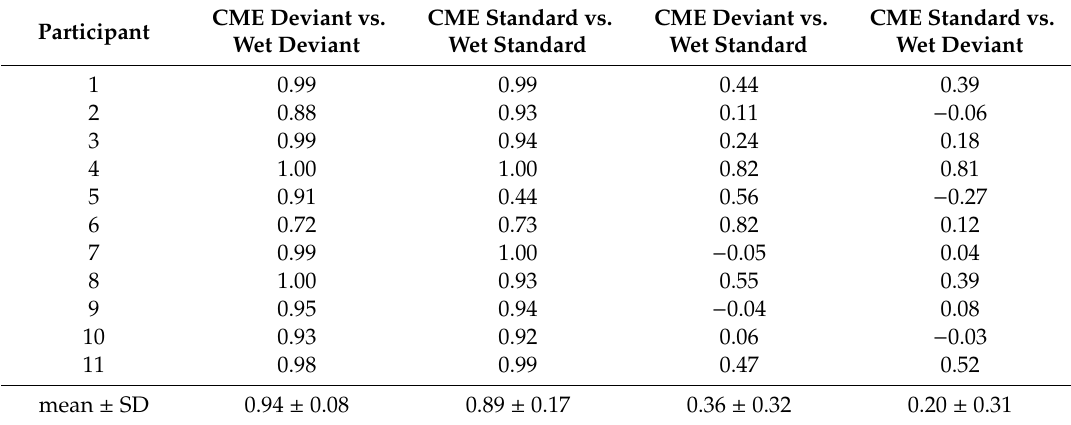
Figure 4. Grand averaged signal measured at Cz from participant 1 acquired with ( a ) CMEs and ( b ) wet electrodes. In both cases, mismatch negativity (MMN) and P300 were observed. Table 1. Correlation between the signals after the deviant and standard stimuli acquired with CMEs and the wet electrodes.